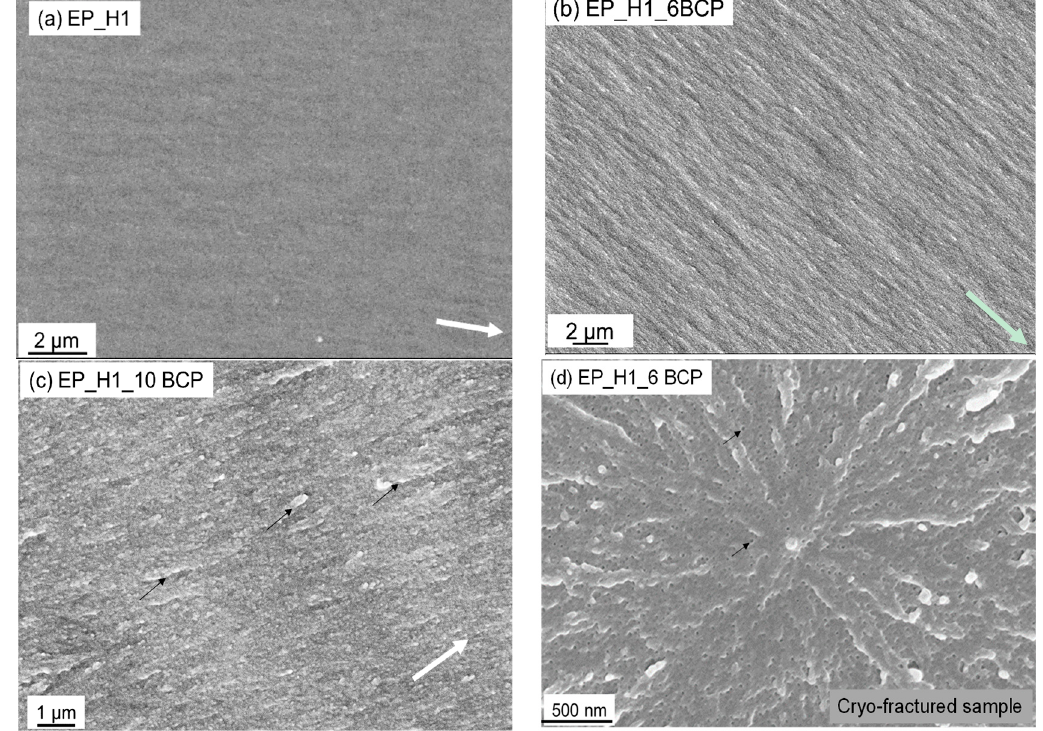
Figure 6 . Field emission scanning electron microscope (FE-SEM) micrograph showing the fracture surface of different epoxy systems. ( a ) Reference epoxy system, ( b ) EP_6BCP system, ( c ) EP_10BCP and ( d ) Cryofractured sample of EP_6BCP system. Black arrows representing the small-scale matrix tearing in ( c ) and cavities in ( d ). White arrow indicates the direction of crack propagation.